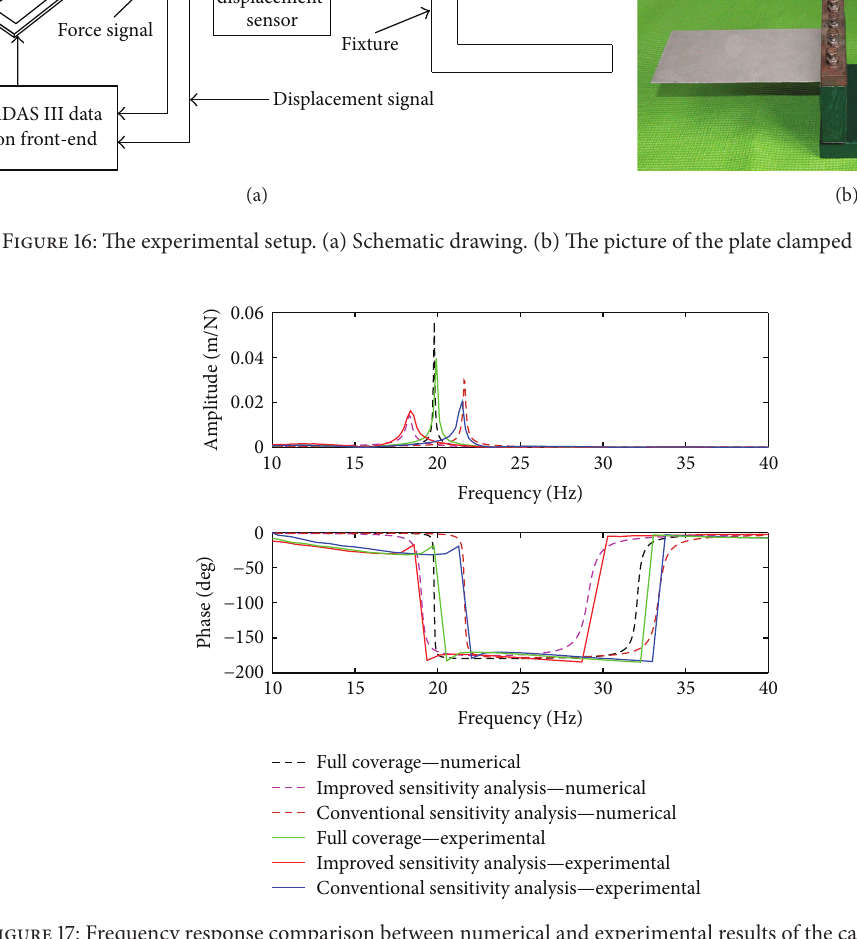
Figure 17: Frequency response comparison between numerical and experimental results of the cantilever